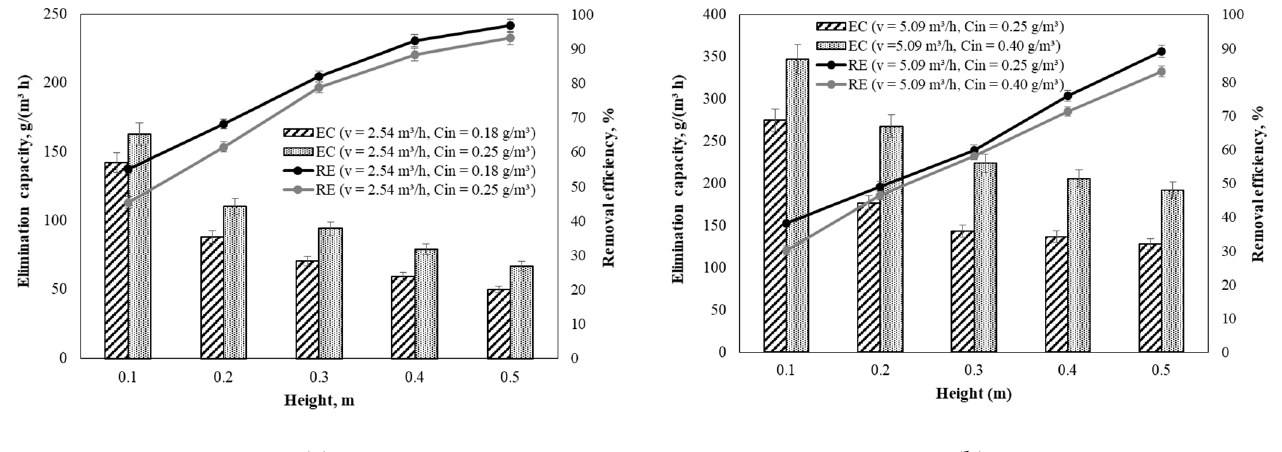
Figure 8. The dependence of the acetone removal efficiency and its elimination capacity on the height of the packing material: ( a ) at the air-flow rate of 2.54 m 3 /h and inlet concentration of 0.18–0.25 g/m 3 ; ( b ) at the air-flow rate of 5.09 m 3 /h and inlet concentration of 0.25–0.40 g/m 3 . Values correspond to the average removal efficiencies and elimination capacities obtained during each phase.